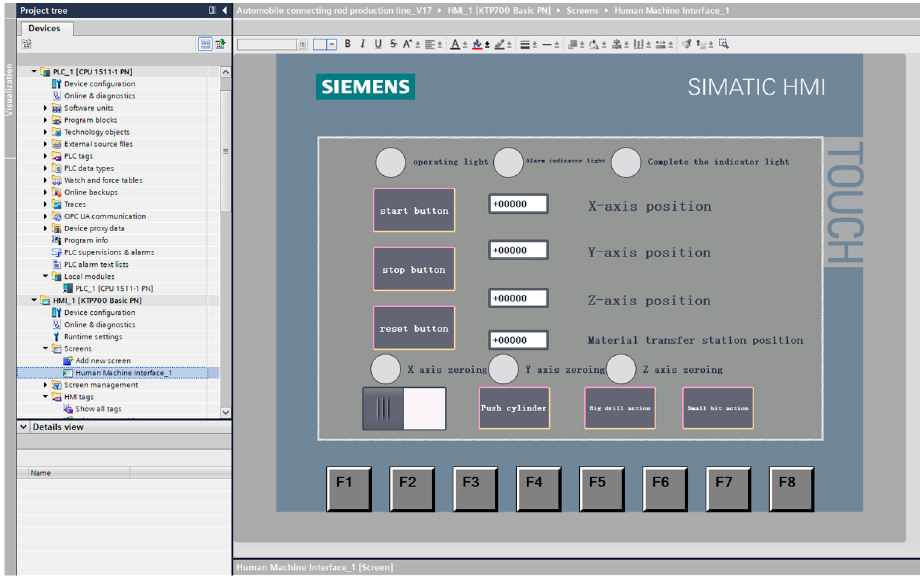
Appl. Sci. 2023 , 13 , x FOR PEER REVIEW Figure 13. The Human Machine Interface. Figure 13. The Human Machine Interface.